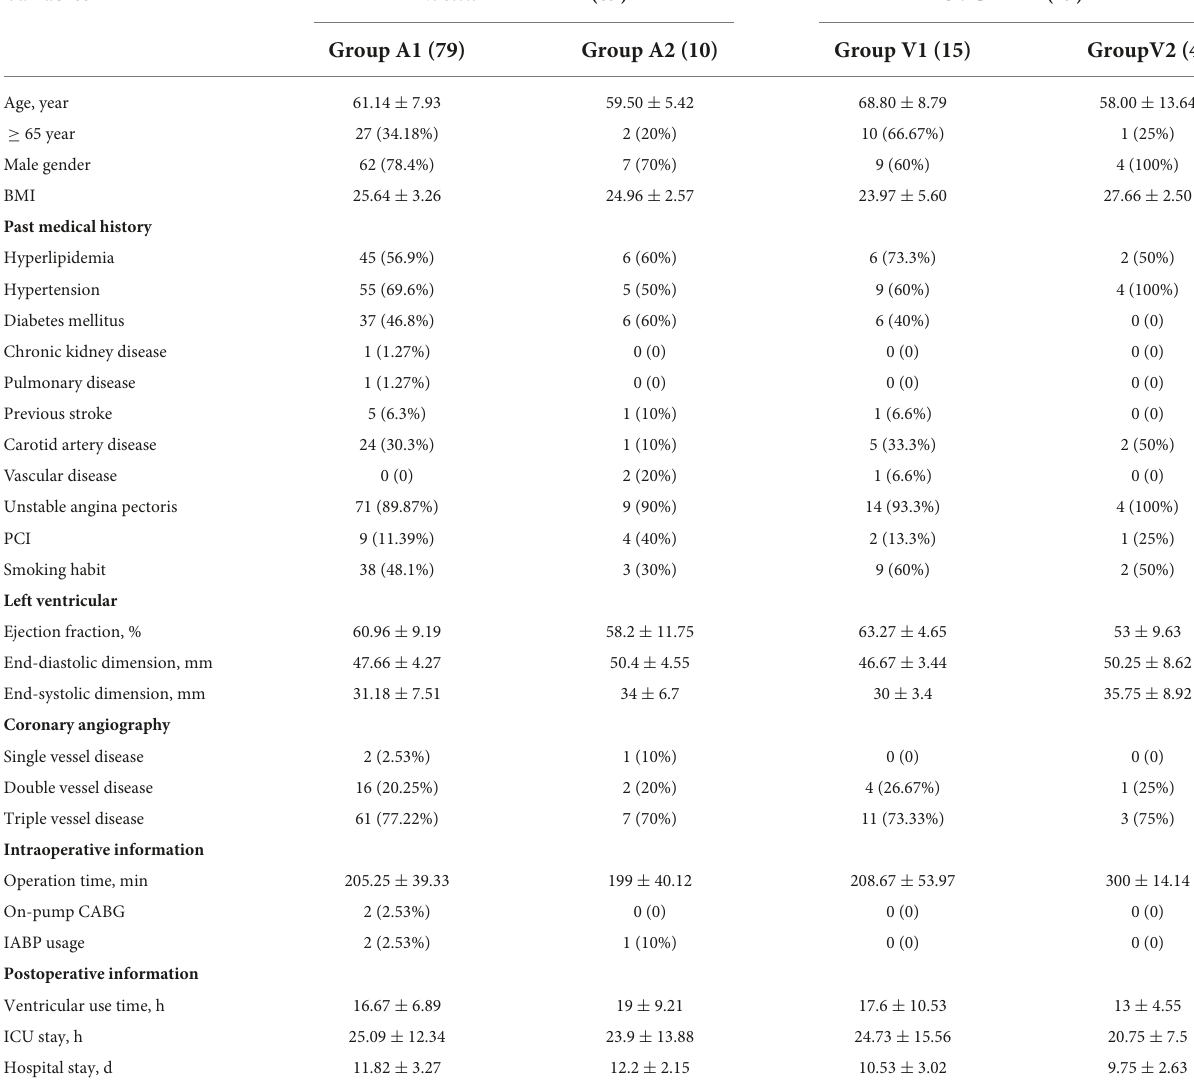
TABLE 1 Patient